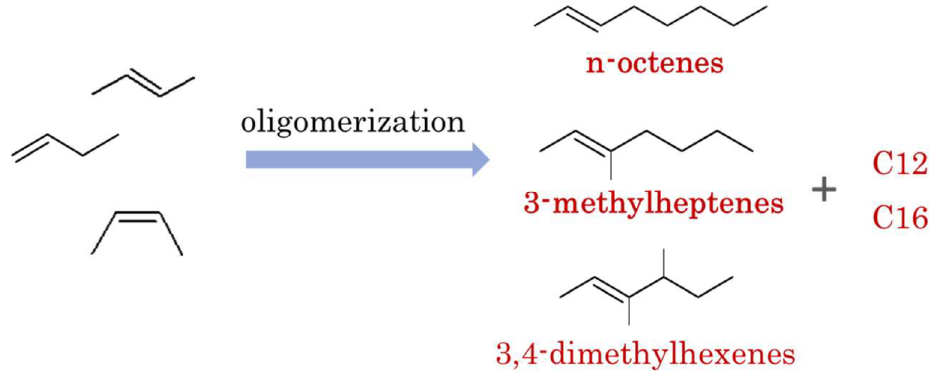
Figure 1. Oligomerization of n-butenes to linear n-octenes, branched 3-methylheptenes, highly branched 3,4-dimethylhexenes, and long-chain oligomers.